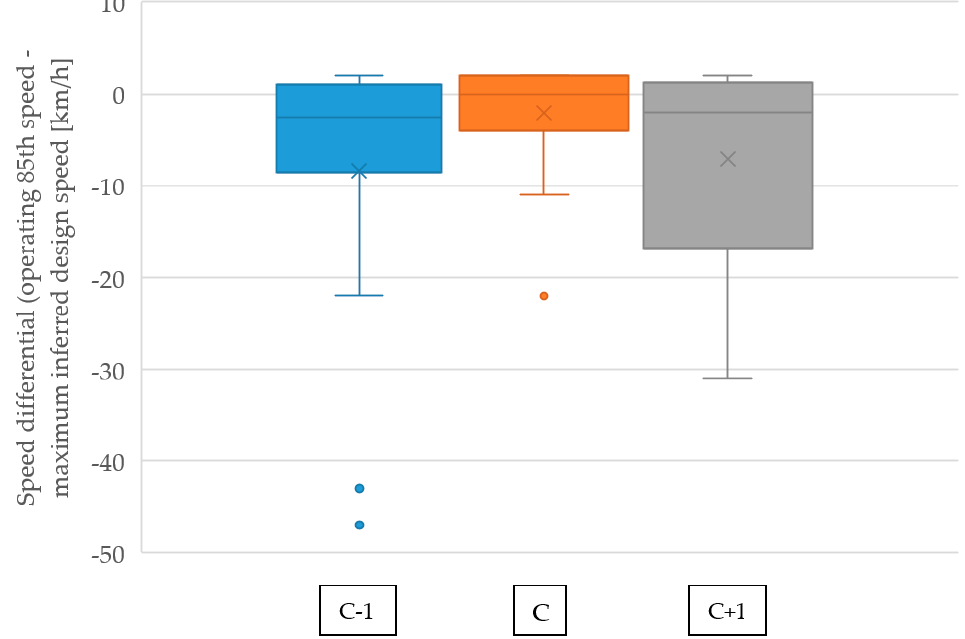
Figure 5. Boxplots of the distribution of speed differentials (operating 85 th —maximum inferred design speed) in dry conditions for the three populations (previous C-1, crash C, following C+1 curves).